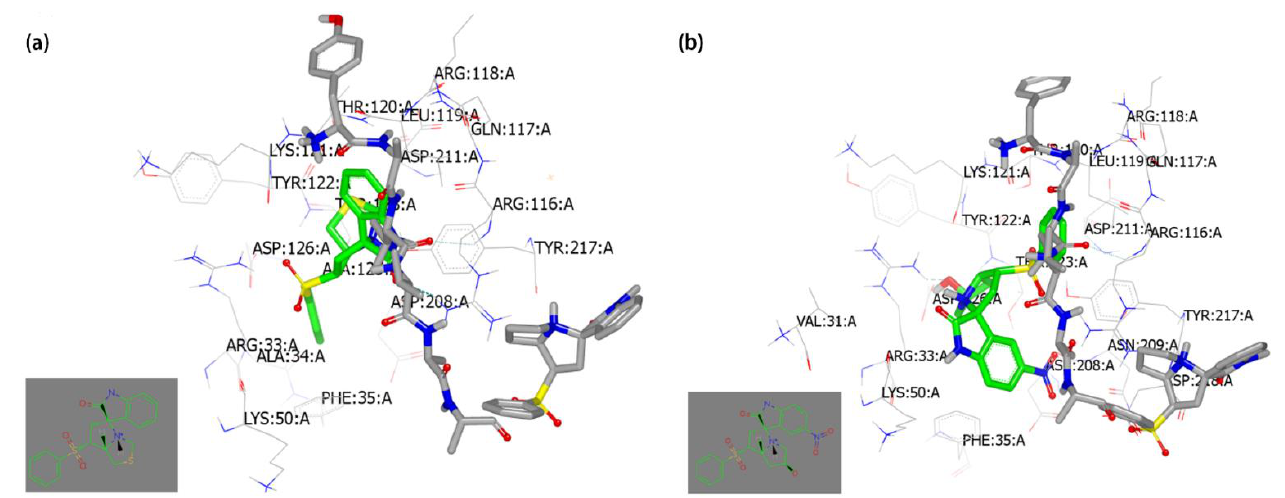
Figure 4. Visual representation for the combination compounds docked against (PDBID: 6m71) ( a ) snapshot of both compounds 4k (grey color) and 4i (green color) in presence of co-crystalized standard ligand (grey). The HB illustrated in green color; ( b ) snapshot of both compounds 4k (grey color) and 4c (green color) in presence of co-crystalized standard ligand (grey).